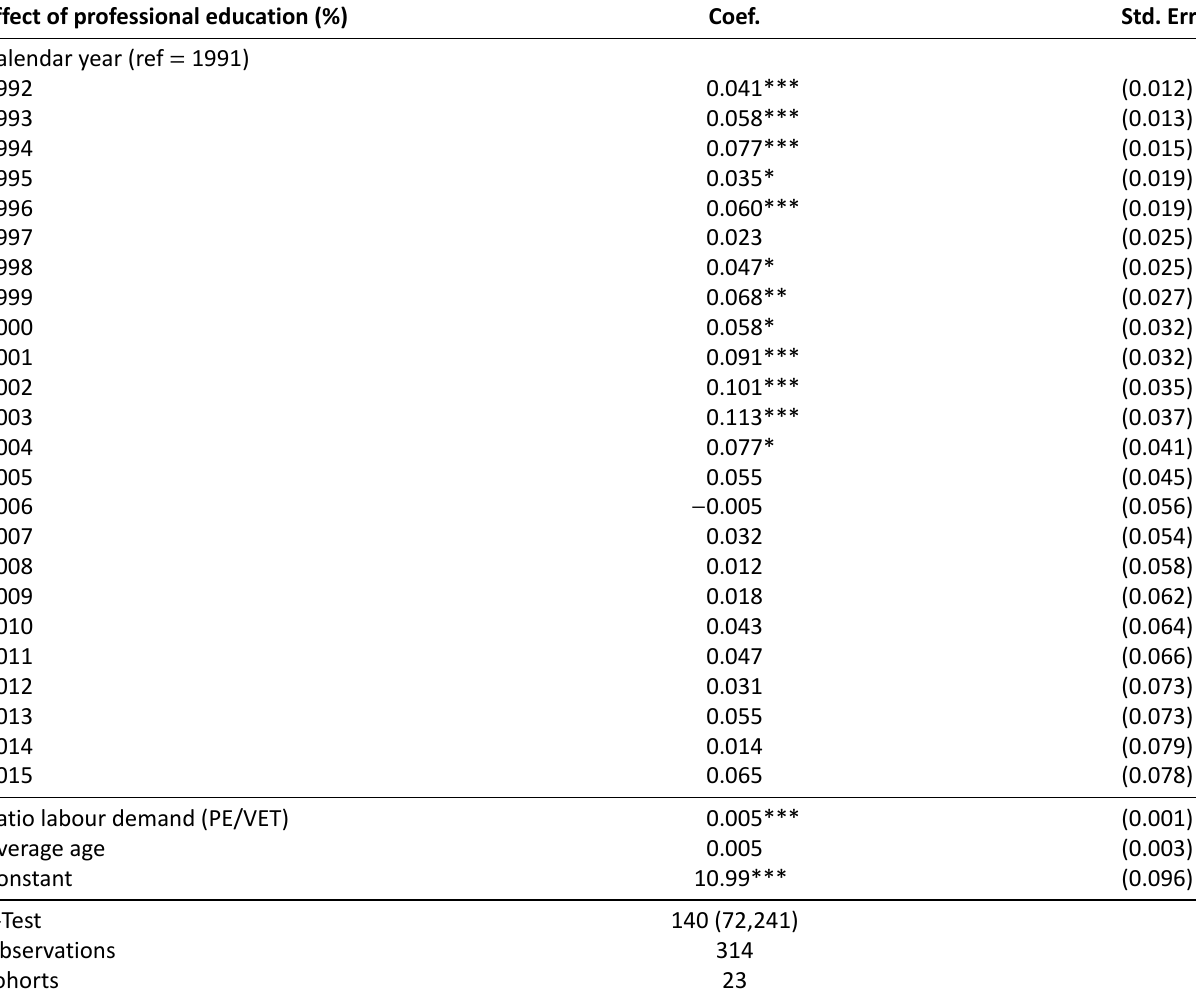
Table A2. (Cont.) Model I—Results of (weighted) quasi-panel fixed effects regression.